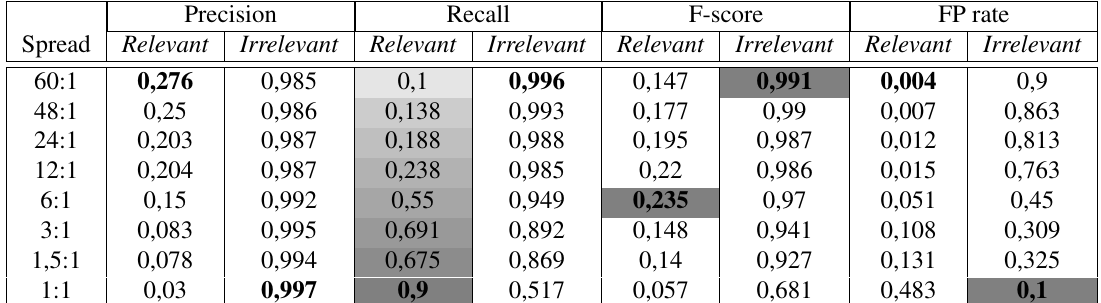
Table 10: Results of BN classifier for category E when applying different spread for random un- dersampling.